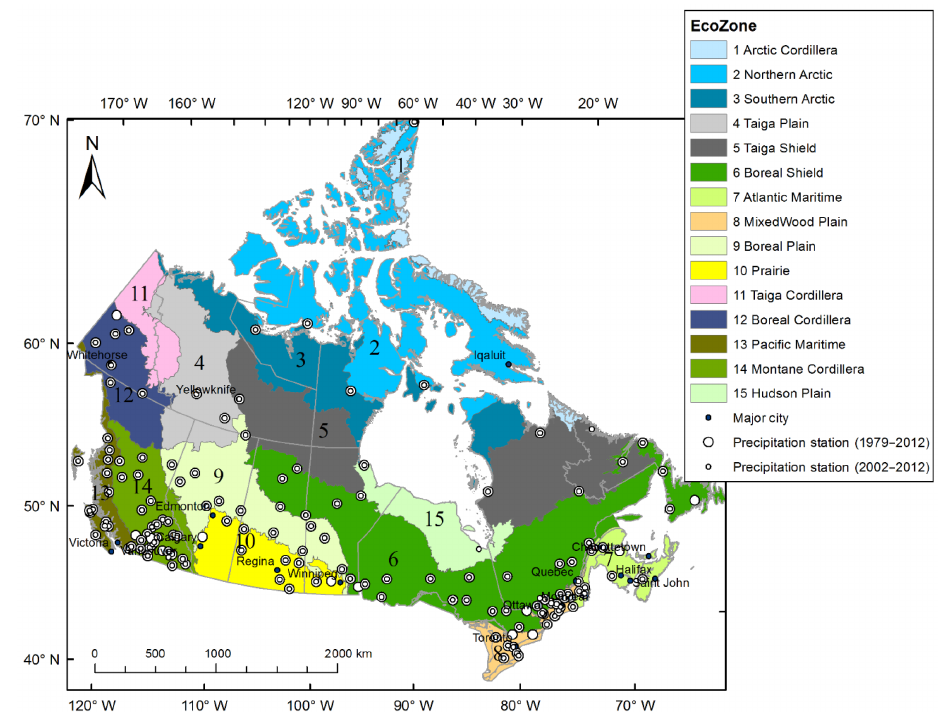
Figure 1. In total, 15 terrestrial ecozones of Canada with numerical codes indicating regions from 1 (Arctic Cordillera) to 15 (Hudson Plain). Big (a total of 145) and small (a total of 137) white dots are the extracted precipitation-gauge stations from the Canadian adjusted and homogenized precipitation datasets of Mekis and Vincent (2011) for the period of 1979 to 2012 and 2002 to 2012 respectively. Black dots are major cities in